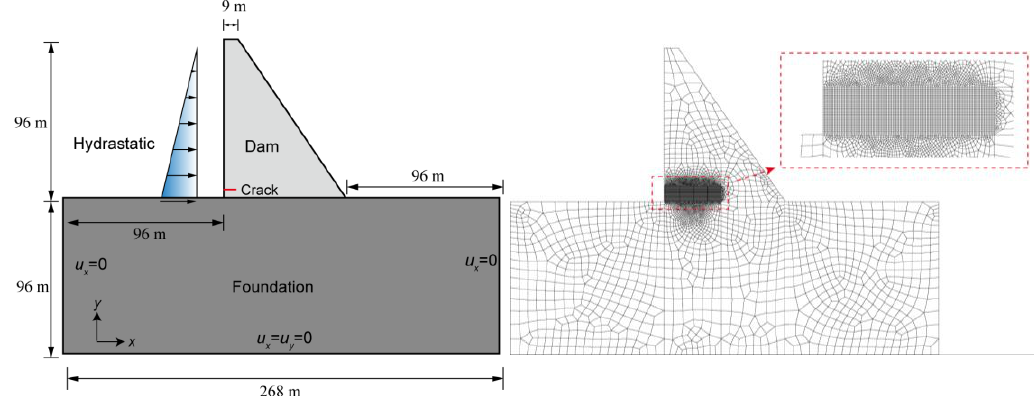
Figure 15. A concrete gravity dam under hydrostatic pressure: the geometry, boundary conditions ( left ), and XFEM meshes ( right ).